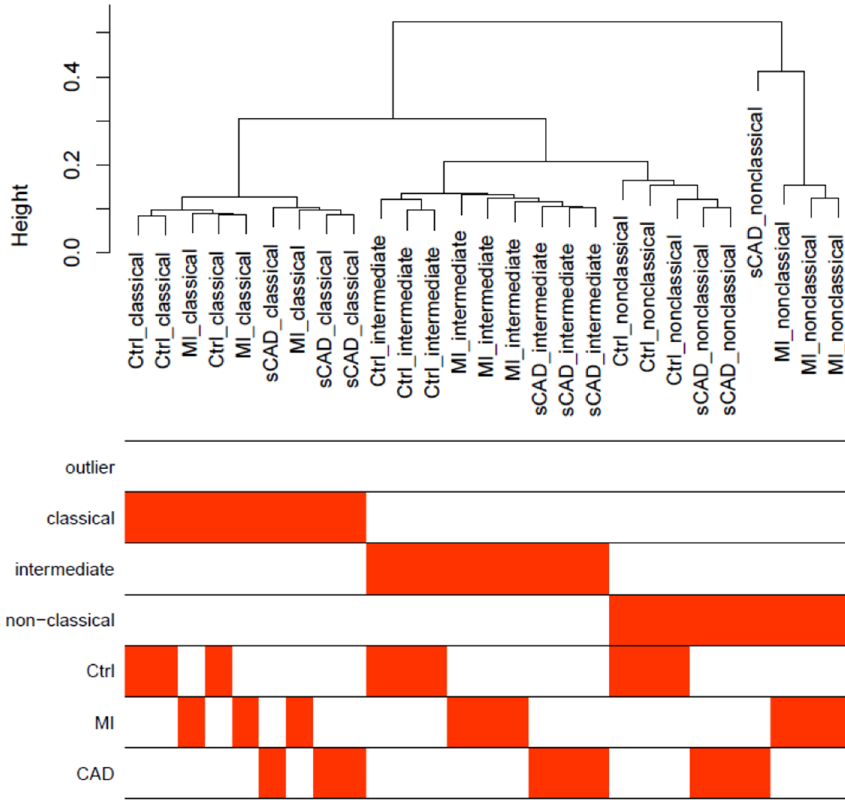
Figure 2. Analysis of miRNA expression raw data from sorted blood monocyte subpopulations of controls, MI patients and CAD patients. Hierarchical clustering of control and patients’ samples are shown as sample dendrogram and trait heat